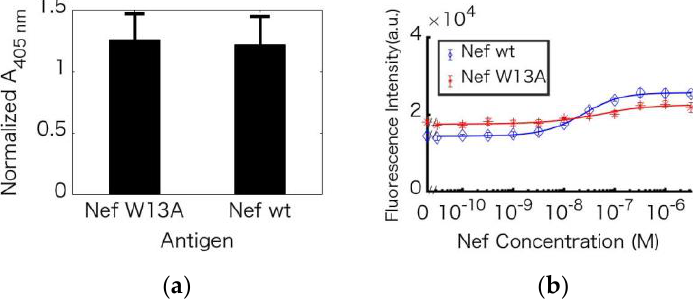
Figure 7. Antigen-dependent enhancement of fluorescence of the Nef Q-body with mutated Nef. ( a ) Specific binding of L67LAzY to Nef wt and Nef W13A. ( b ) Titration curve of the fluorescence intensity with Nef wt (blue line) and Nef W13A (red line). Error bars represent ±1 S.D. (n = 3).